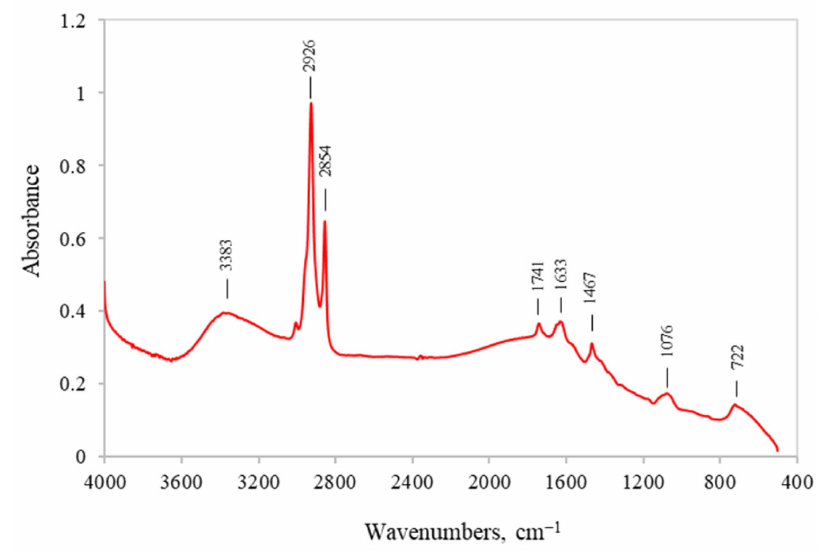
Figure 3. FTIR spectra of bis(2-hydroxyethyl)ammonium